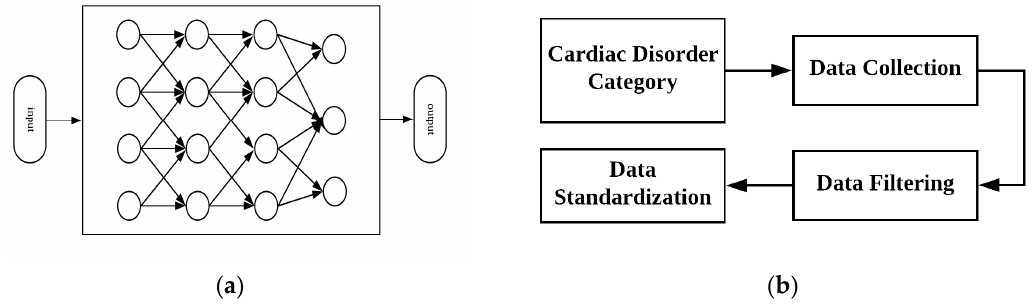
Figure 4. ( a ) Neural network composed of many interrelated neurons; ( b ) Data collection procedure outline.